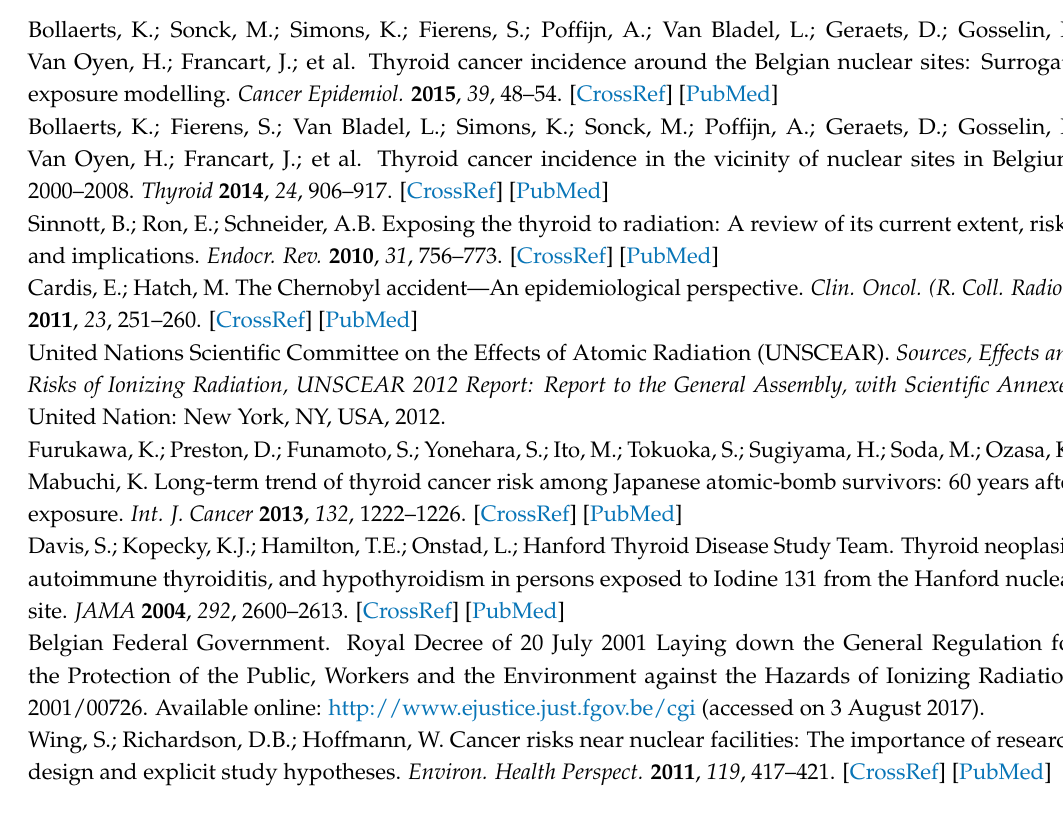
Table S1: Rate ratios of thyroid between 2000 (2004) and 2014 for the 0–5, 5–10, 10–15, and 15–20 km proximity area around each nuclear site and the four Belgian nuclear sites